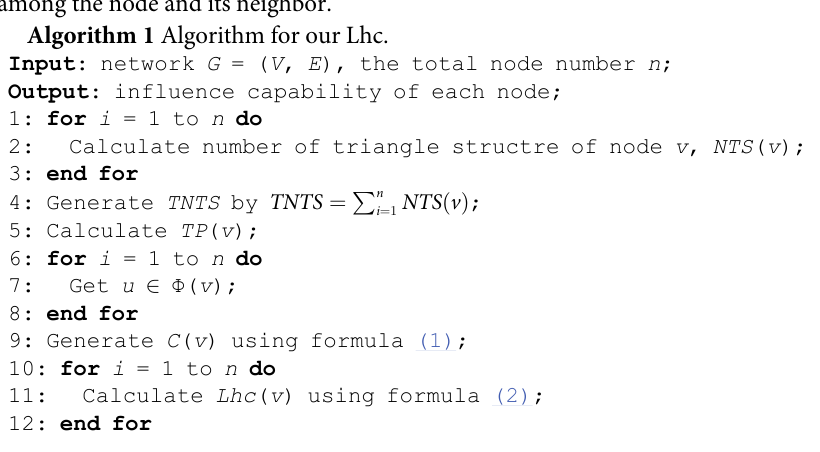
Algorithm 1 Algorithm for our